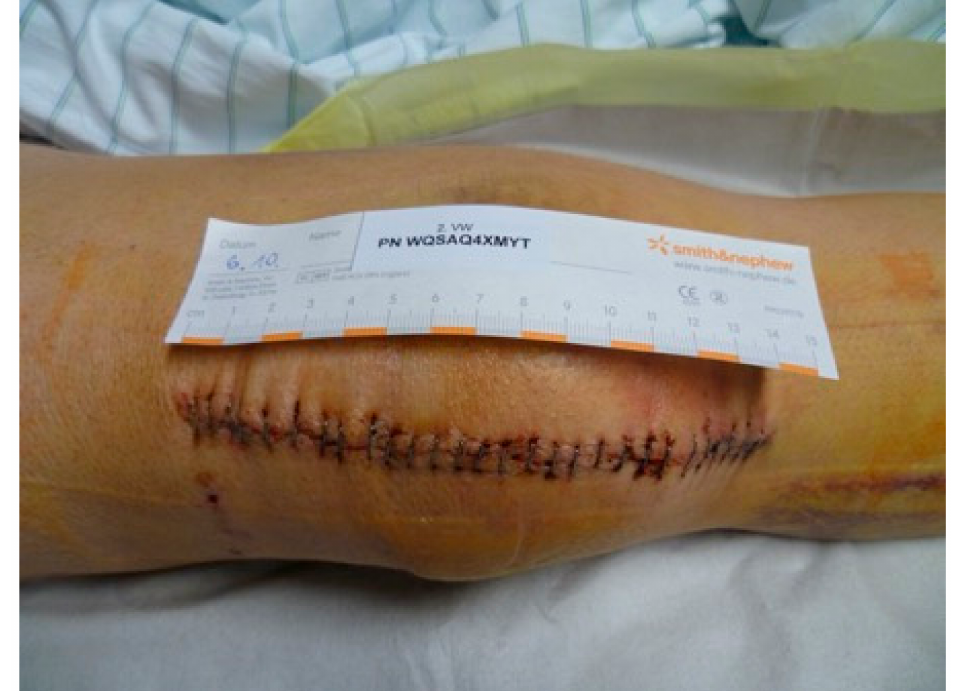
Figure 4. Study group: second dressing change (fifth postoperative day).